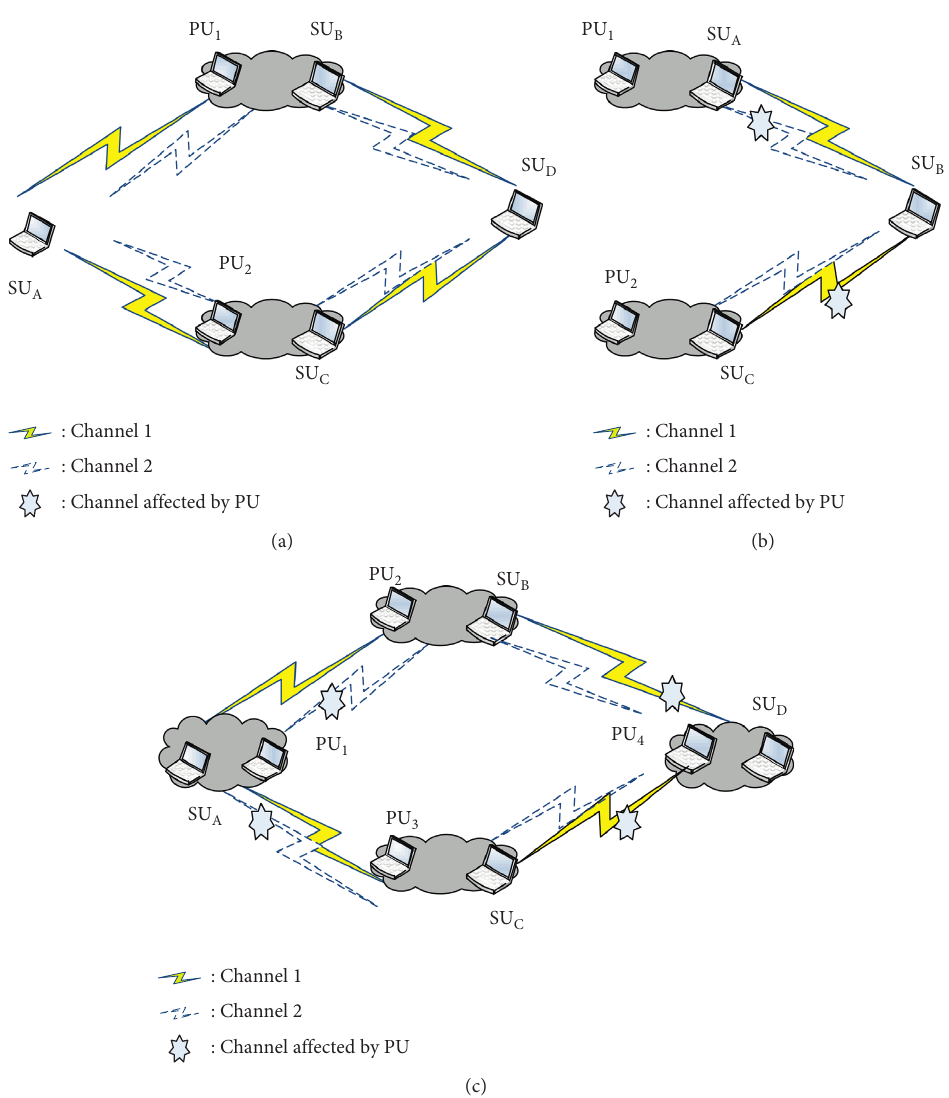
Figure 11: Network model of proposed routing